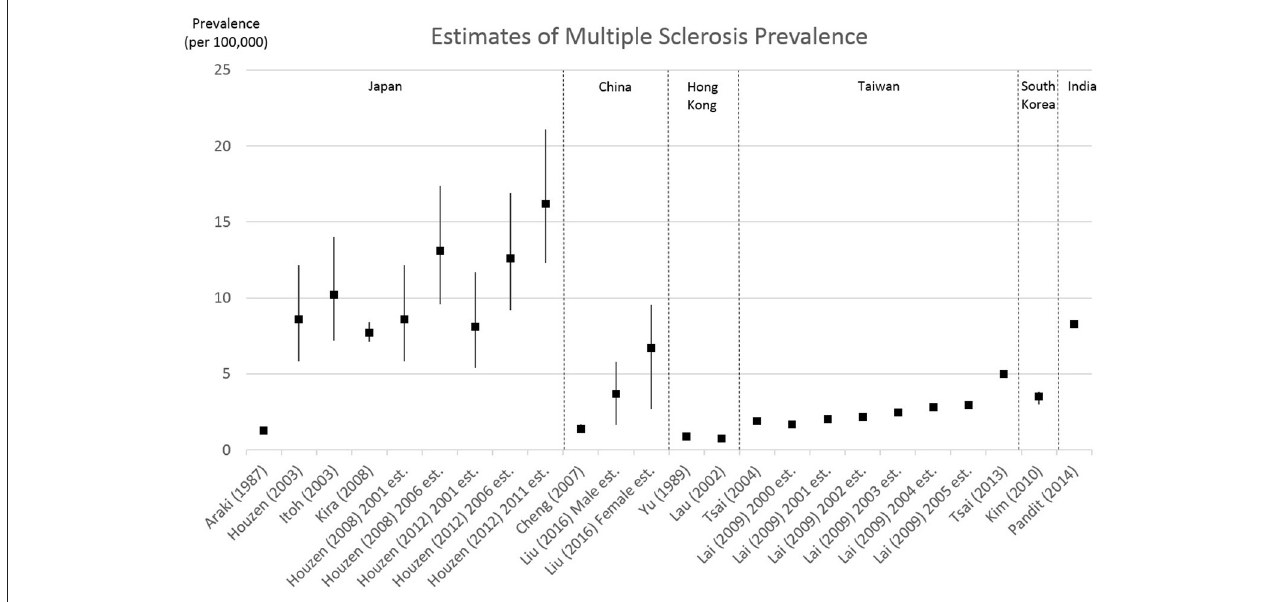
FIGURE 2 | Estimates of multiple sclerosis prevalence from the articles reviewed. Bars represent reported 95% confidence intervals.